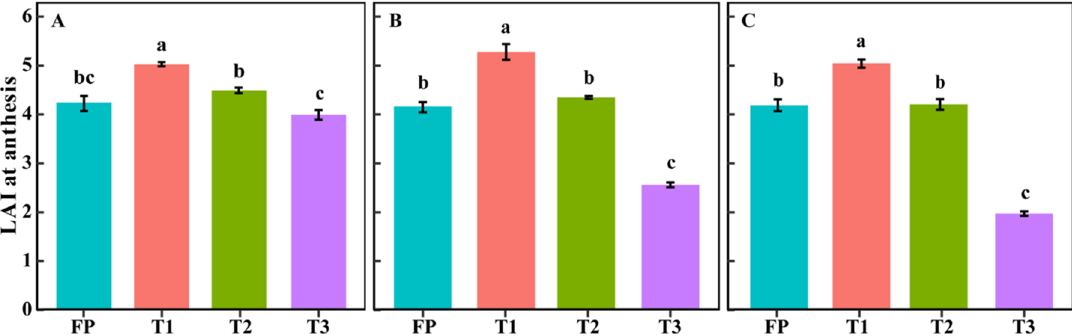
Figure 2. Leaf area index (LAI) of total green leaves at anthesis under different treatments in 2016–2017 ( A ), 2017–2018 ( B ), and 2018–2019 ( C ) growing seasons. Different letters in the figure indicate statistical differences among treatments (LSD p < 0.05 ). The SLA of flag leaf at anthesis under T1 and T2 treatments were lower than that of FP and T3, while the opposite trend was observed in the second leaf and third leaf (Figure 3). It indicated that the flag leaf area of T1 and T2 treatment was thicker and larger than that of other treatments.